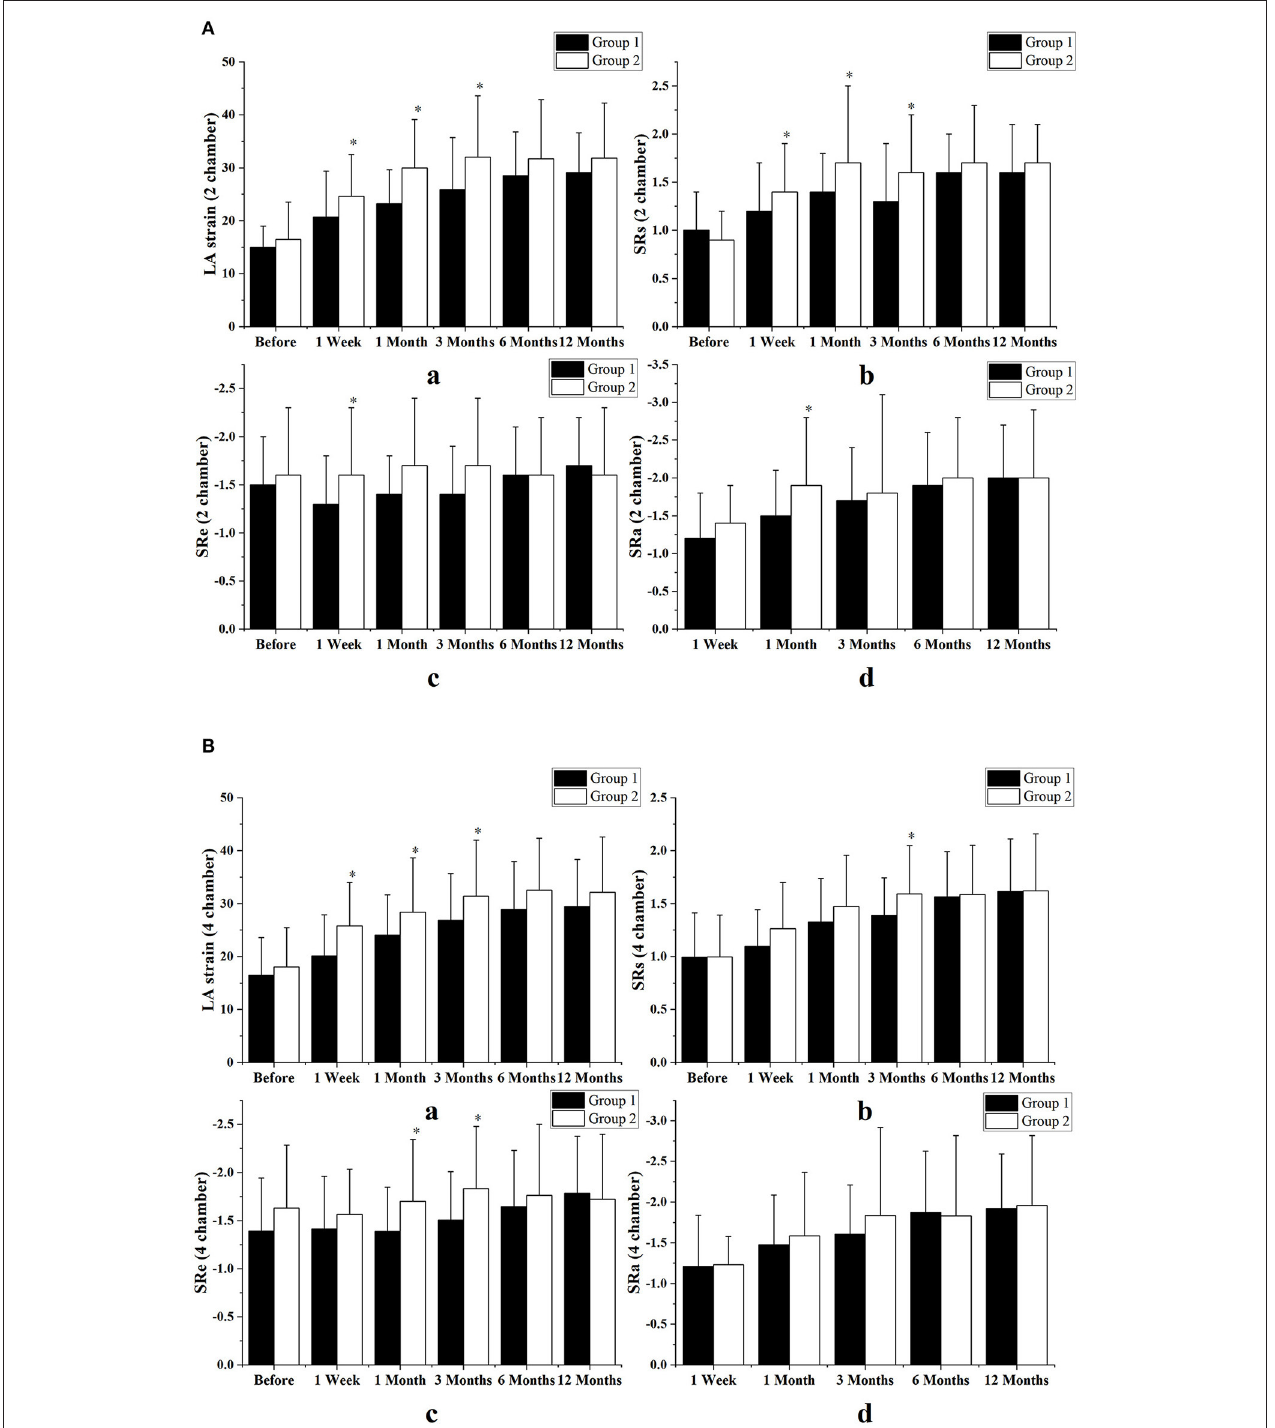
FIGURE 5 | Comparison of left atrial function between the two groups as assessed by strain indices, in echocardiographic views of two chambers (A) and four chambers (B) . All the strain indices had a transient tendency to improve in the patients who underwent catheter ablation alone and the difference between the two groups began very early, between 1 week and 3 months after surgery. However, between months 6 and 12 after surgery, left atrial (LA) function was not significantly different between the two groups. Group 1 consisted of combined therapy group; group 2 consisted of patients who underwent catheter ablation alone. Variables are expressed as means ± standard deviations. SR, strain rate; SRs, strain rate during ventricular systole; SRe, strain rate during early ventricular diastole; SRa, strain rate during atrial systole. * p < 0.05 vs. the combined therapy group at the same follow-up time.